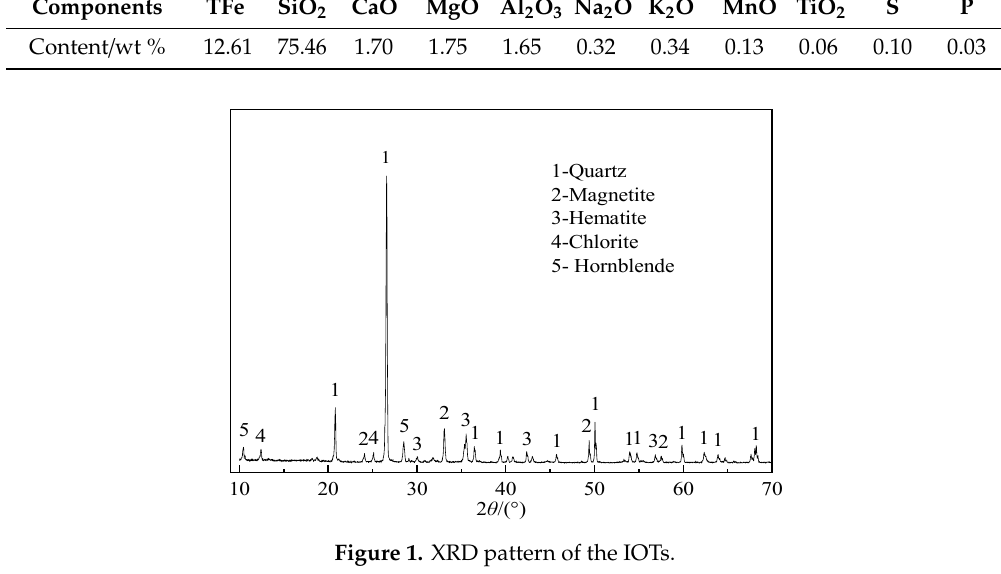
Table 1. Chemical composition of the iron ore tailings (IOTs).